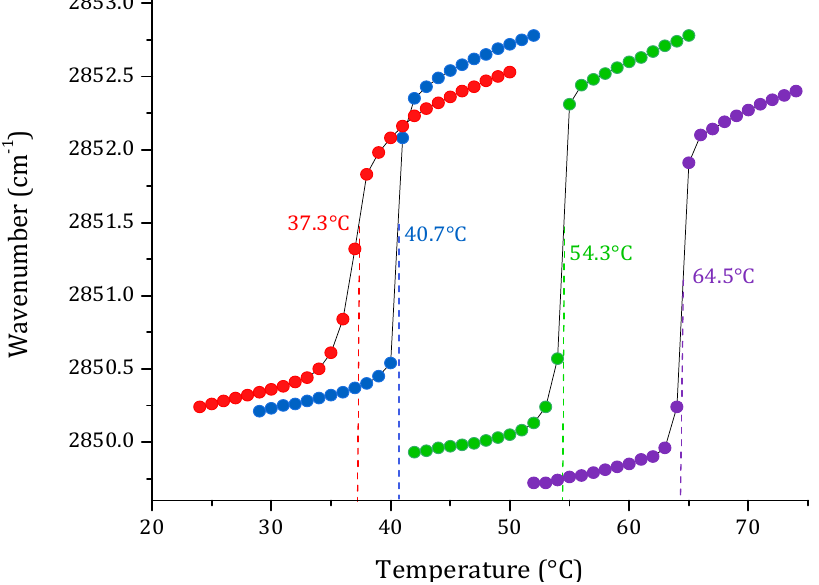
Figure 1. Peak positions of the ν s CH 2 vibration bands of the methylene groups as a function of the temperature of the pure supported lipid bilayers of DPPC ( • ), DPPS ( • ), DPPE ( • ) and SM ( • ) in buffer (10 mM HEPES, 500 mM NaCl, 1 mM EDTA, pH 7.4).